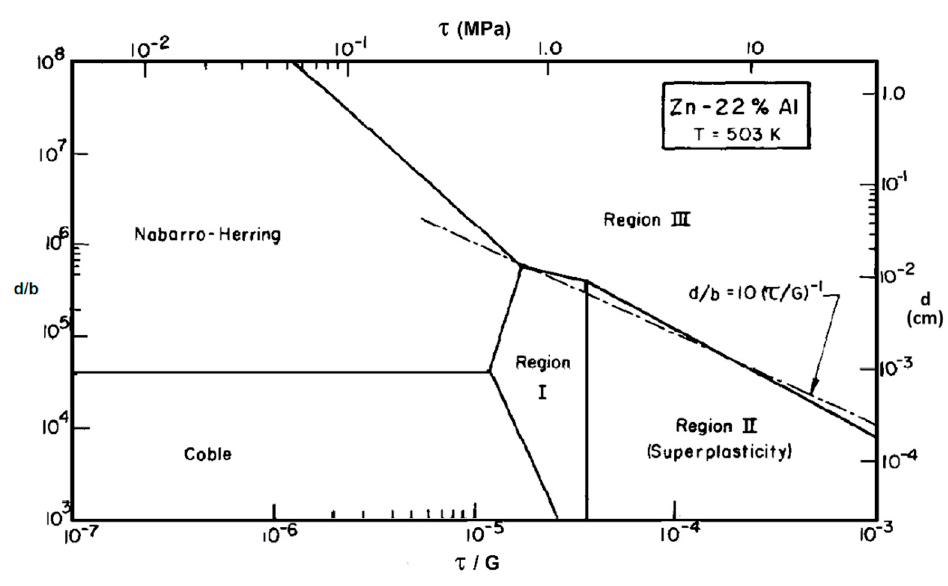
Figure 4. Deformation mechanism map for Zn–22% Al at a temperature of 503 K [25].